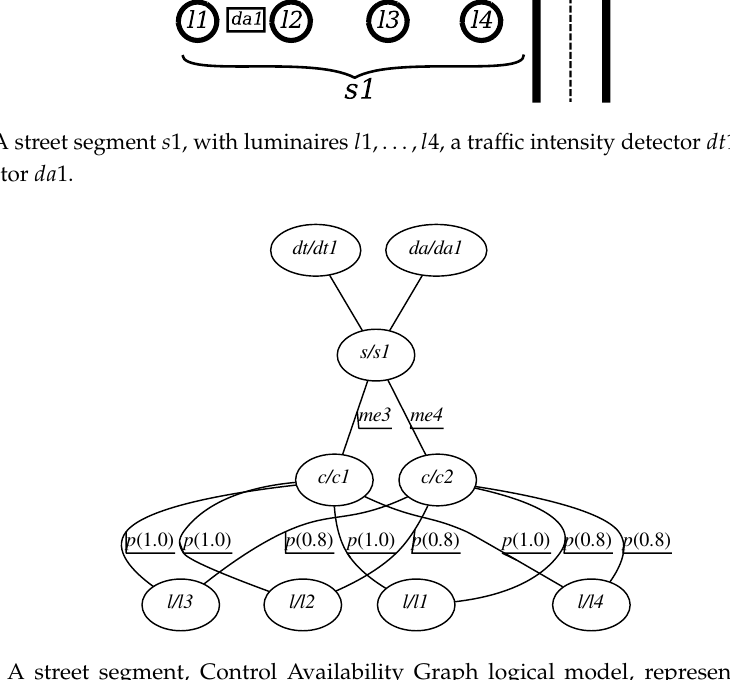
Figure 2. A street segment, Control Availability Graph logical model, representing all features from Figure 1 and luminaire configurations: a traffic intensity detector dt / dt 1, an ambient light intensity detector da / da 1, a segment s / s 1, luminaire configurations c / c 1, c / c 2, luminaires l / l 1, l / l 2, l / l 3, l / l